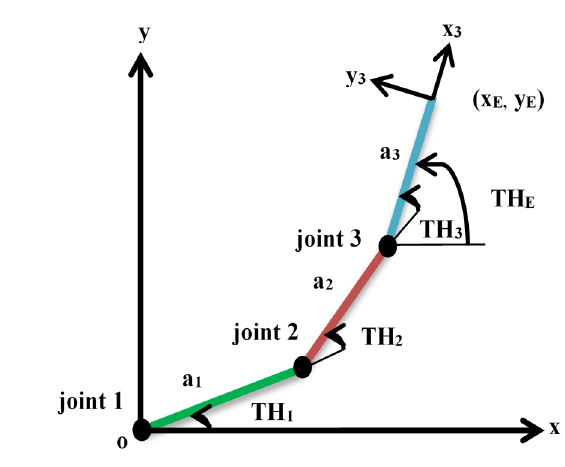
Fig. 1. Three link planner manipulator robot configuration [7].